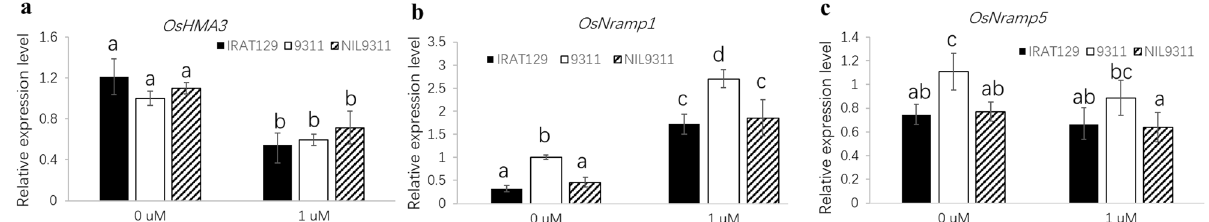
Figure 4. Relative expression of OsHMA3 ( a ), OsNramp1 ( b ) and OsNramp5 ( c ) in rice roots of different lines in the presence or absence of 1 μM Cd. Plants of IRAT129, 9311 and NIL9311-58 were treated with and